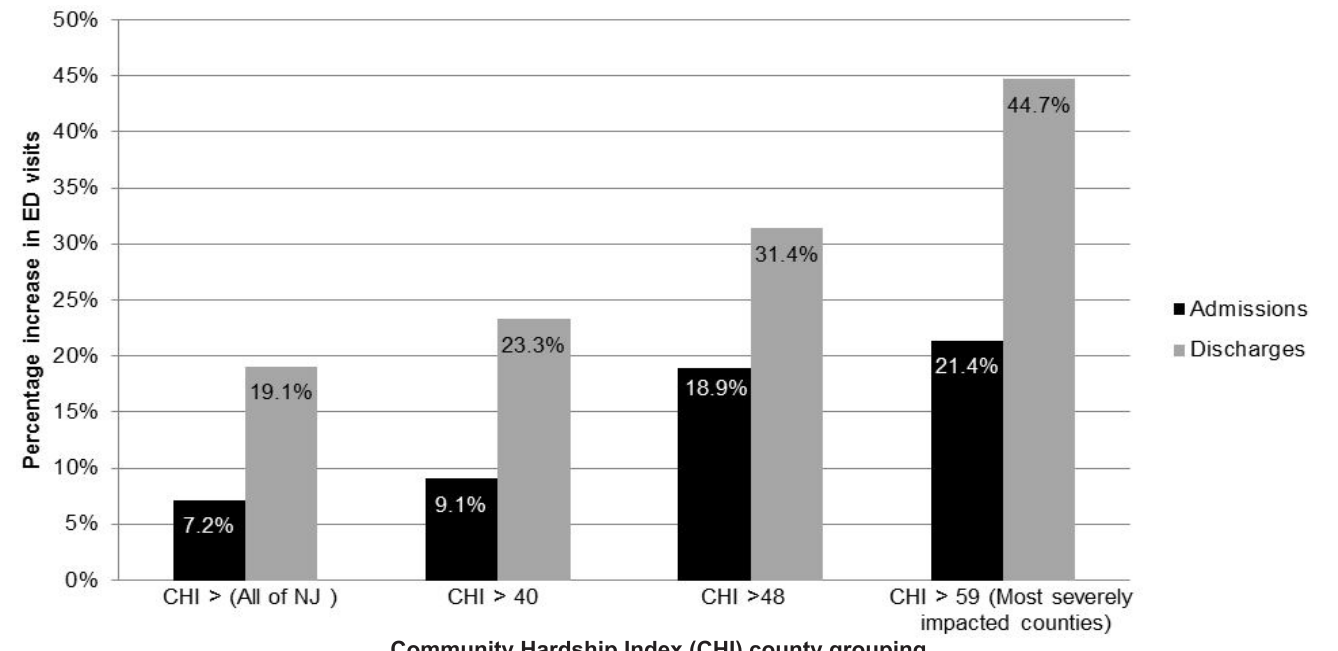
Figure. Percent increase in emergency department (ED) visits by Community Hardship Index (CHI) and ED disposition (2012 vs. 2011).